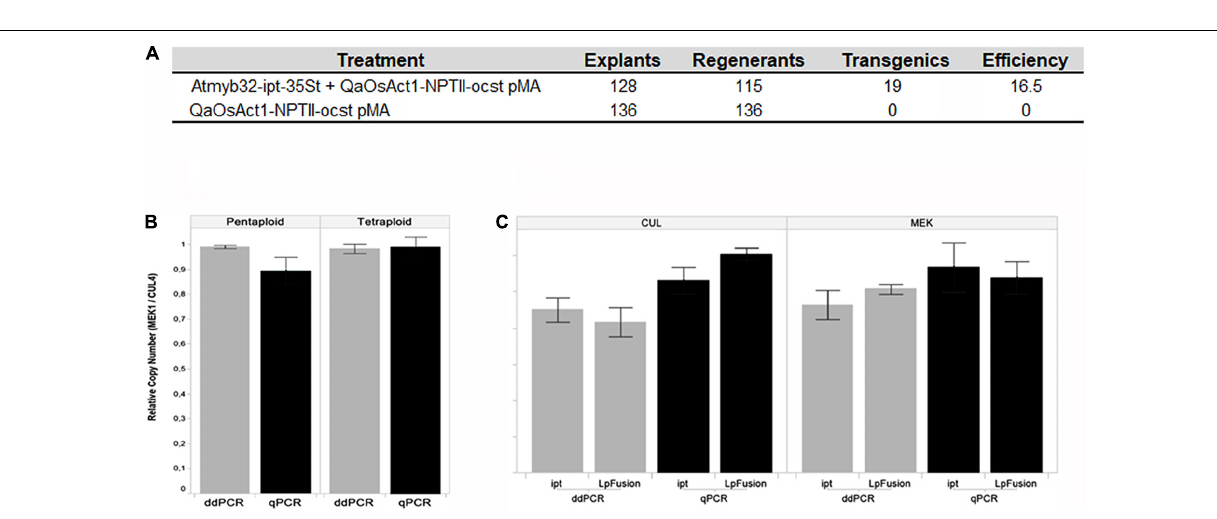
FIGURE 3 | (A) Effect of Atmyb32:ipt on regeneration. Comparison of the efficiency in obtaining transgenic regenerants, in a medium without selector, with or without the Atmyb32: ipt construction. Source: Voda (2021). (B,C) Comparison of qPCR and dd-PCR techniques, (B) in pentaploid and tetraploid genotypes. Histograms indicate the relationship between two unique copied endogenous genes ( Cul4 and Mek1 ), (C) in copy number detection of two transgenes (ipt and LpFusion ) using two endogenous reference genes ( Cul4 and Mek1 ). Histograms indicate the average of copy number. Vertical lines indicate the standard deviation. Source: Voda